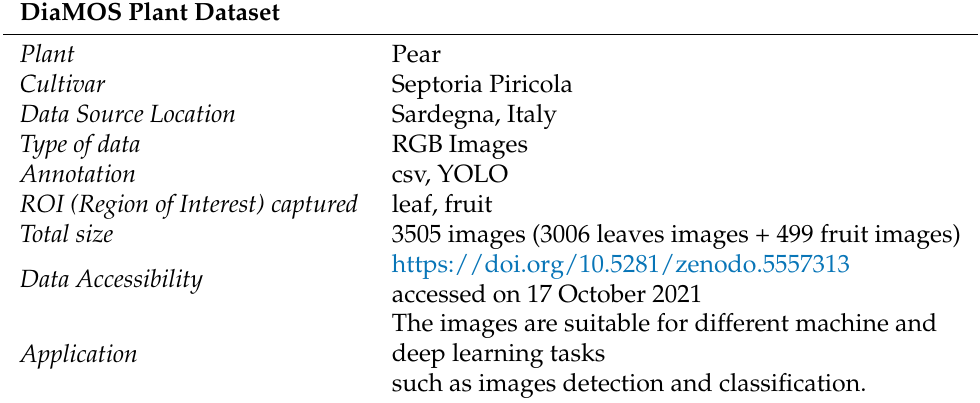
Table 1. Dataset description.